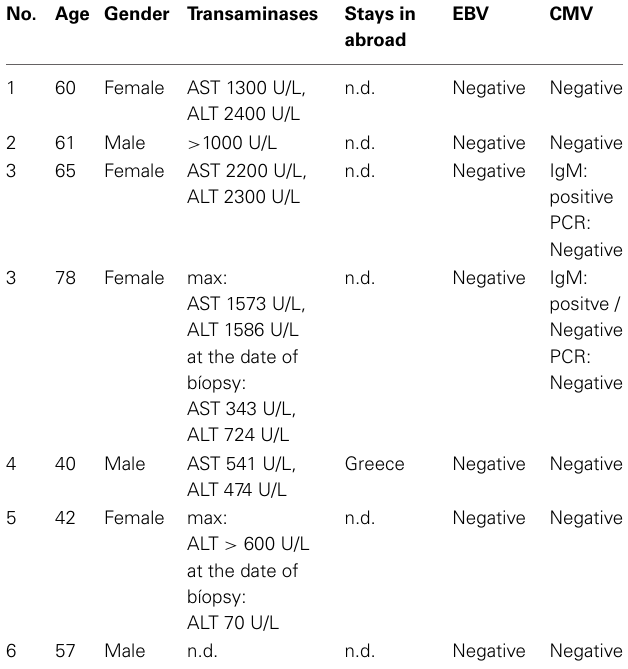
Table 2 | Characteristics of Patients with Acute Hepatitis E.